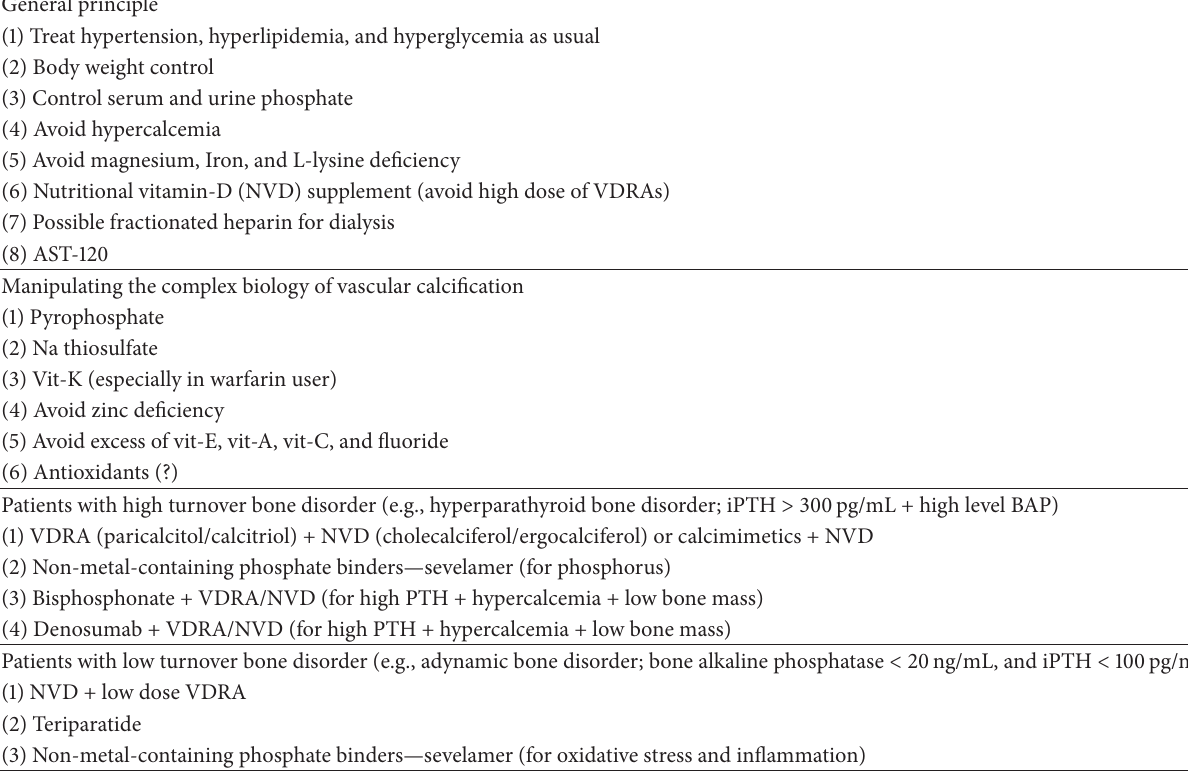
Table 1: The possible treatments of vascular calcification in